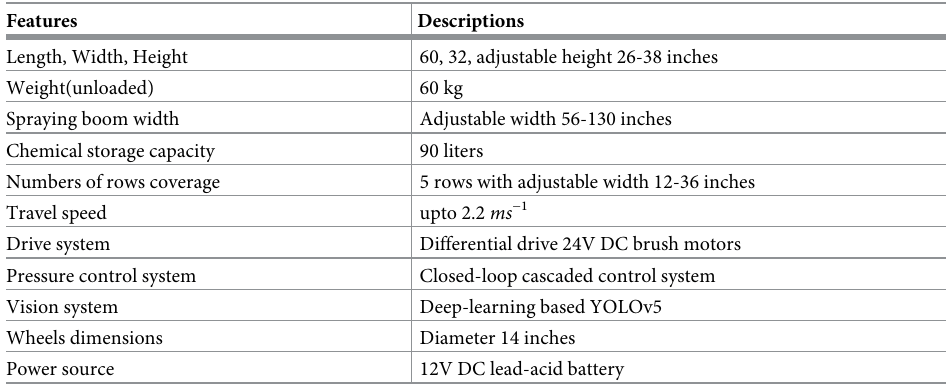
Table 1. Agricultural sprayer robot specifications.